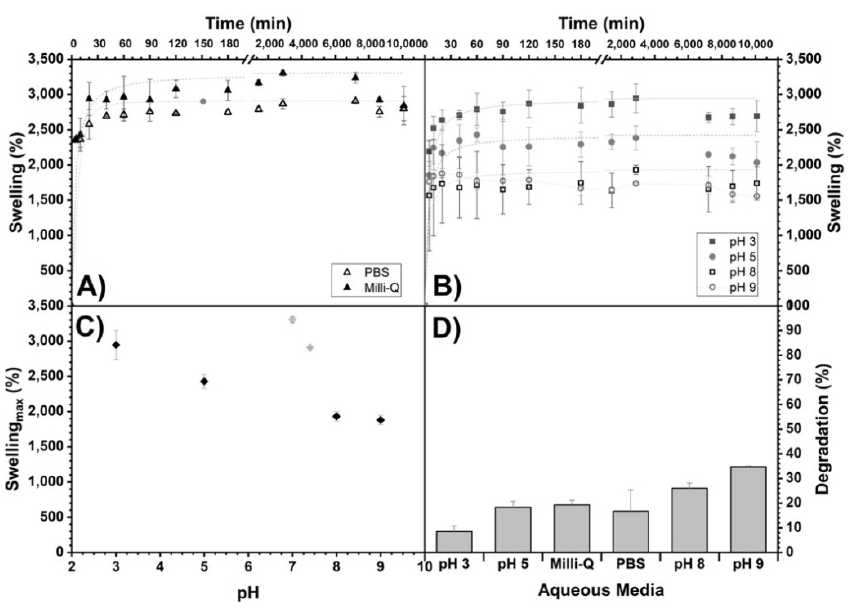
Figure 3. Swelling of alginate/chitosan scaffolds (Method 3) as a function of time in different aqueous media: ( A ) Milli-Q and PBS and ( B ) buffers prepared with Na 2 HPO 4 /citric acid for pH 3, 5, 8 and 9. In addition, their maximum swelling ( S max ) as a function of pH ( C ) and the percentages reached with respect to S max at 5, 40 and 60 min are shown (see Table 1). Maximum swelling trend lines are shown as an eye guide. ( D ) Percentage of degradation (%) of the scaffolds of Method 3 (more crosslinking time) as a function of the aqueous medium exposed for 7 days. Table 1. Maximum swelling ( S max ) as a function of pH.